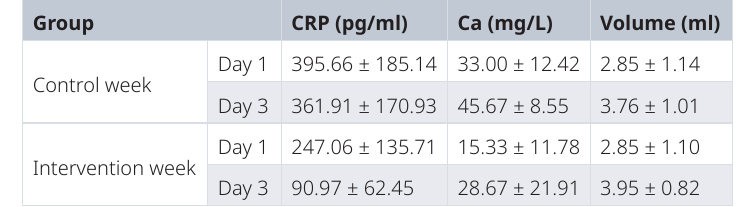
Table 1. Volume, CRP and Ca levels in saliva of subjects consuming bubble tea with (intervention) and without (control) tapioca pearls